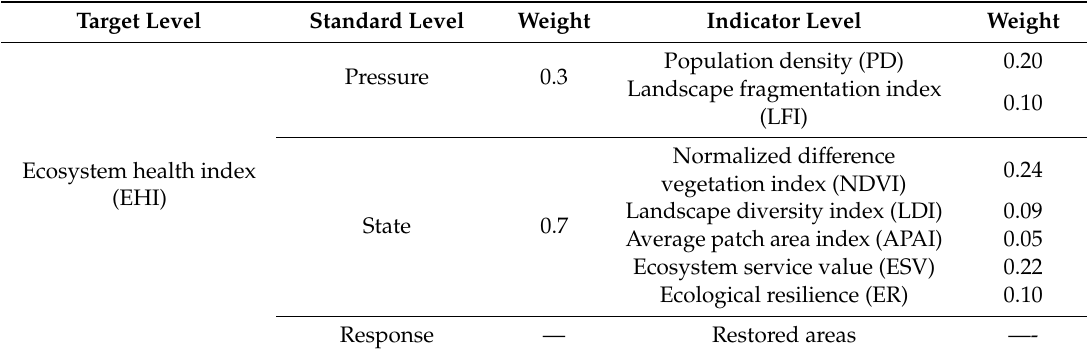
Table 2. The Pressure-State-Response (PSR) framework and the weight of each indictor.